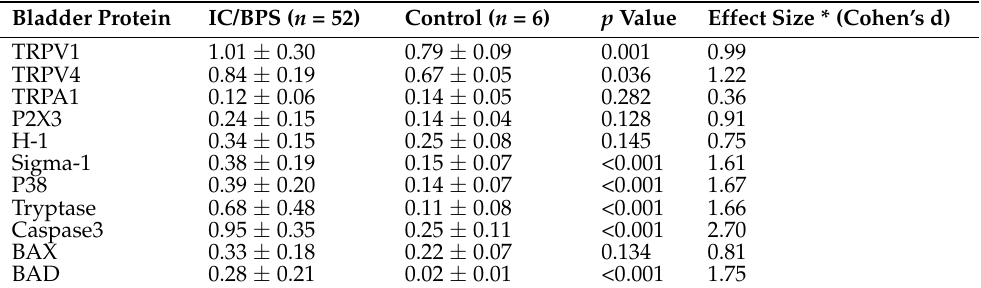
Abbreviations: as in text. Data are presented as mean ± standard deviation of the relative density of sensory, inflammatory, and pro-apoptotic protein expression to GAPDH, using Western blotting analysis, in the bladder tissue of IC/BPS and controls. * The magnitudes of effect size are 0.20, 0.50, 0.8, and 1.2 for small, moderate, large, and very large effects, respectively. In the correlation analysis among all IC/BPs patients and controls, TRPV1 negatively associated with bladder volume (r = − 0.294) and bladder compliance (r = − 0.313), TRPV4 positively associated with voiding detrusor pressure (r = 0.278), and P2X3